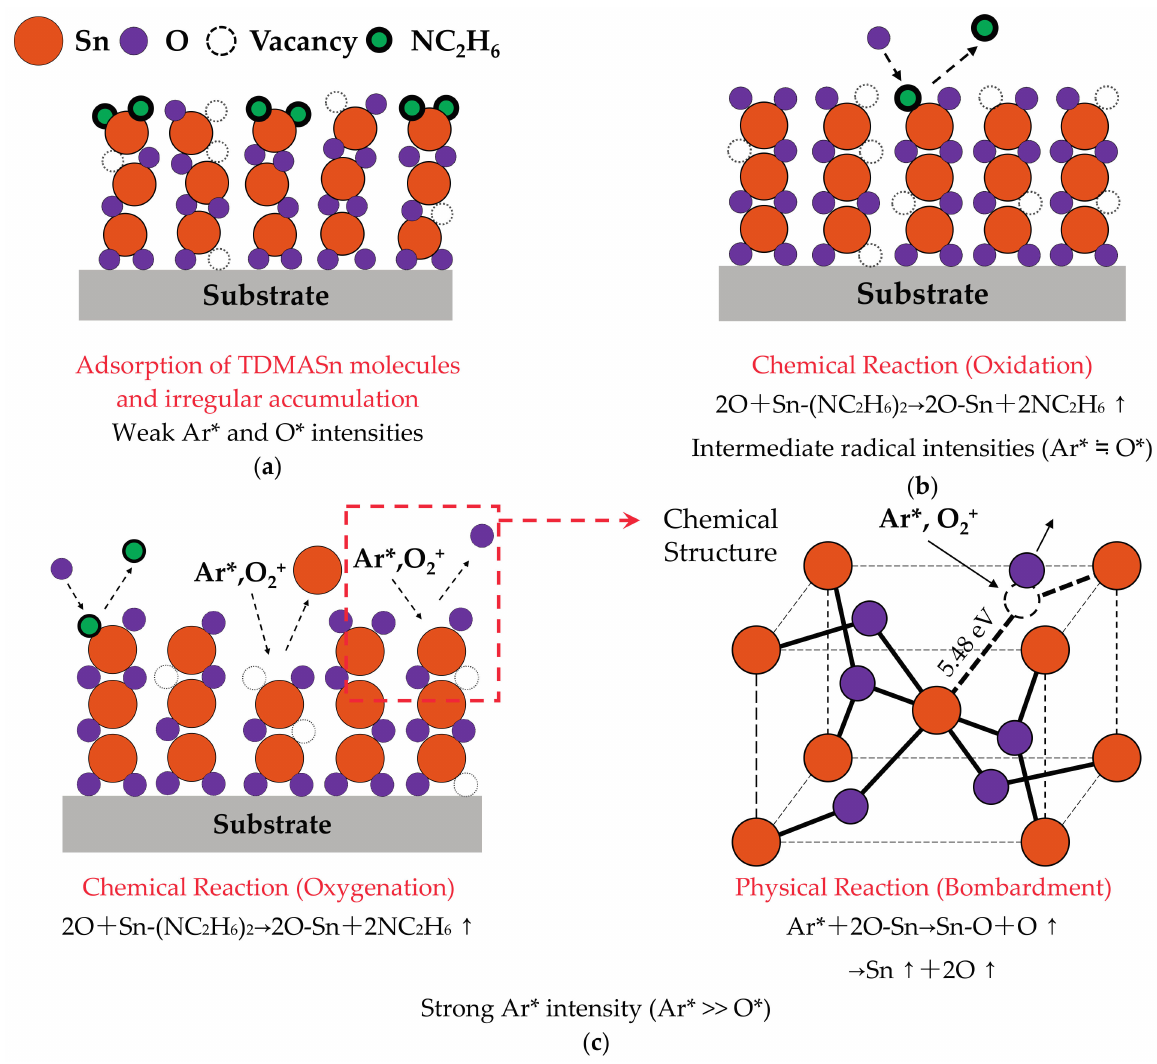
Figure 2. Deposition mechanisms of PEALD SnO 2 thin films under three kinds of Ar* and O* intensities: ( a ) weak, ( b ) similarly intermediate